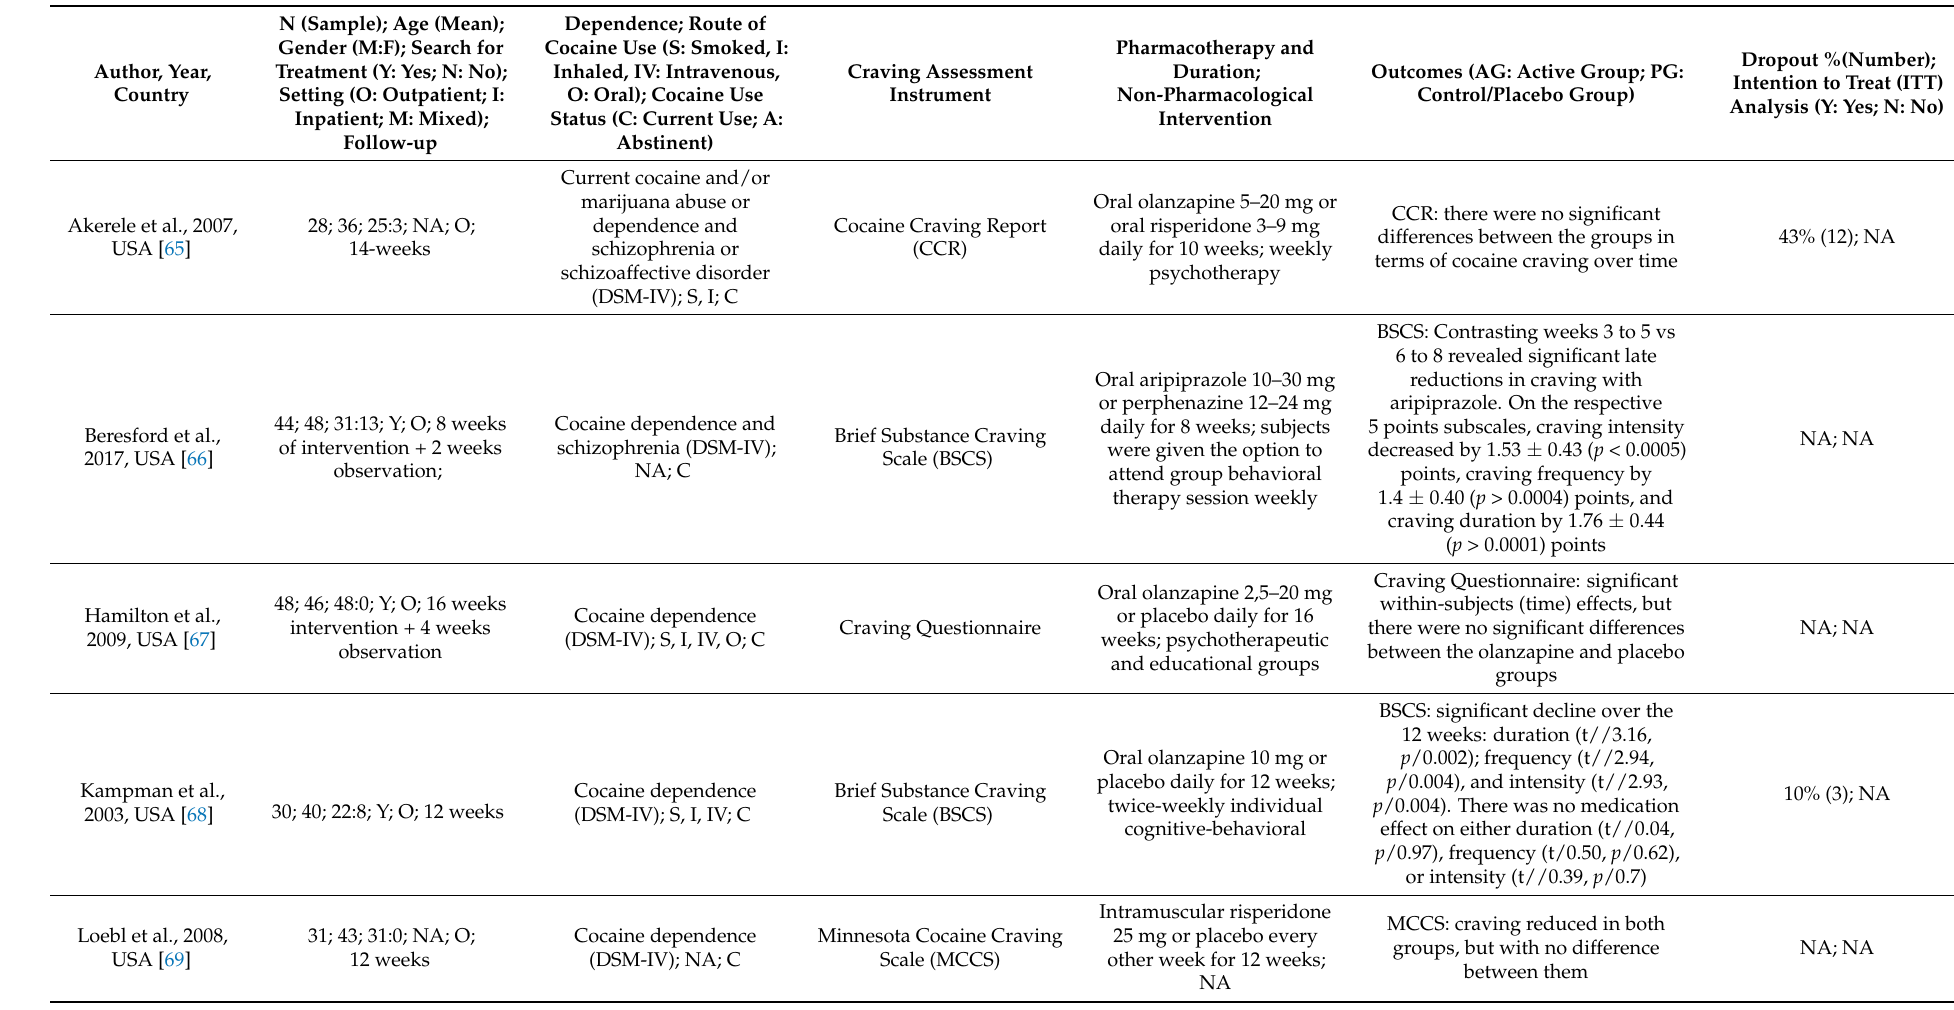
Table 3. Characteristics and main findings of the studies included in the systematic